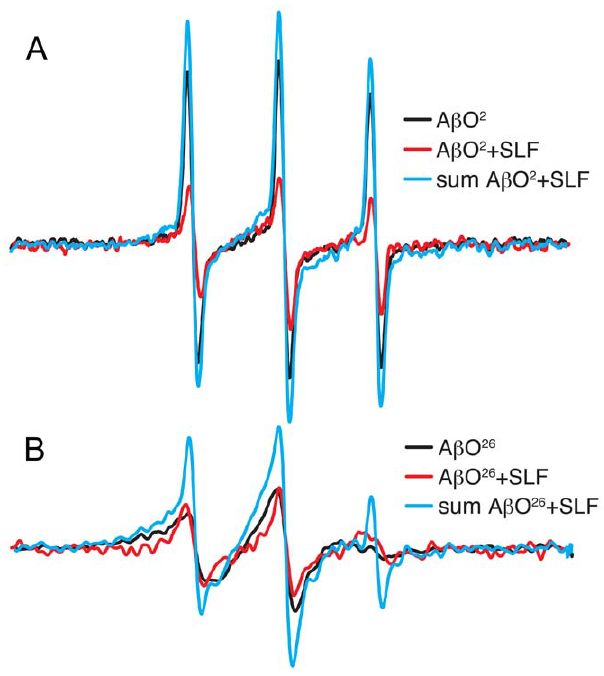
Figure 9. The comparison of EPR spectra from A b alone, an actual mixture of SLF and A b , and the mathematical sum of the individual EPR signals from SLF and A b . Data were taken for samples containing A b O spin labeled at the 2 nd residue (A) and for samples containing A b O spin labeled at the 26 th residue (B).